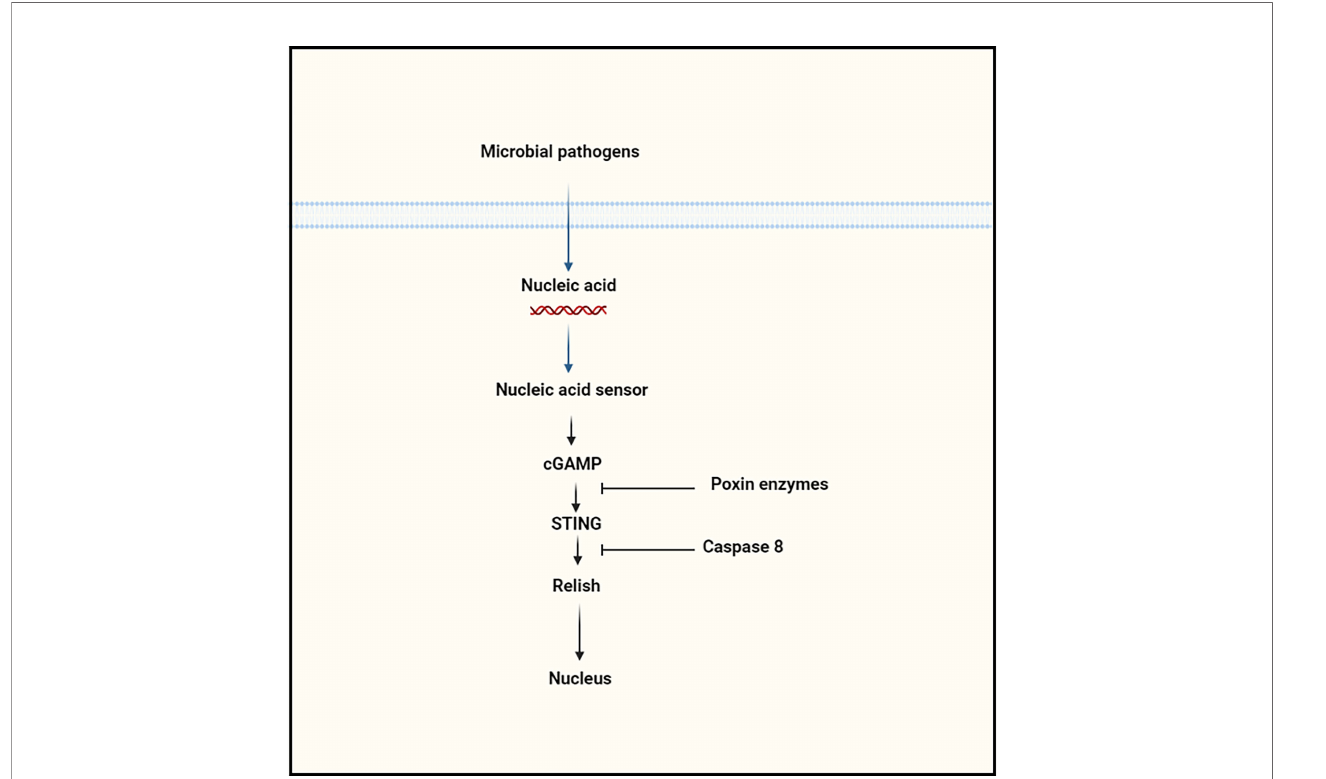
FIGURE 4 | The regulation of cGAS – STING signaling pathway by proteins at various